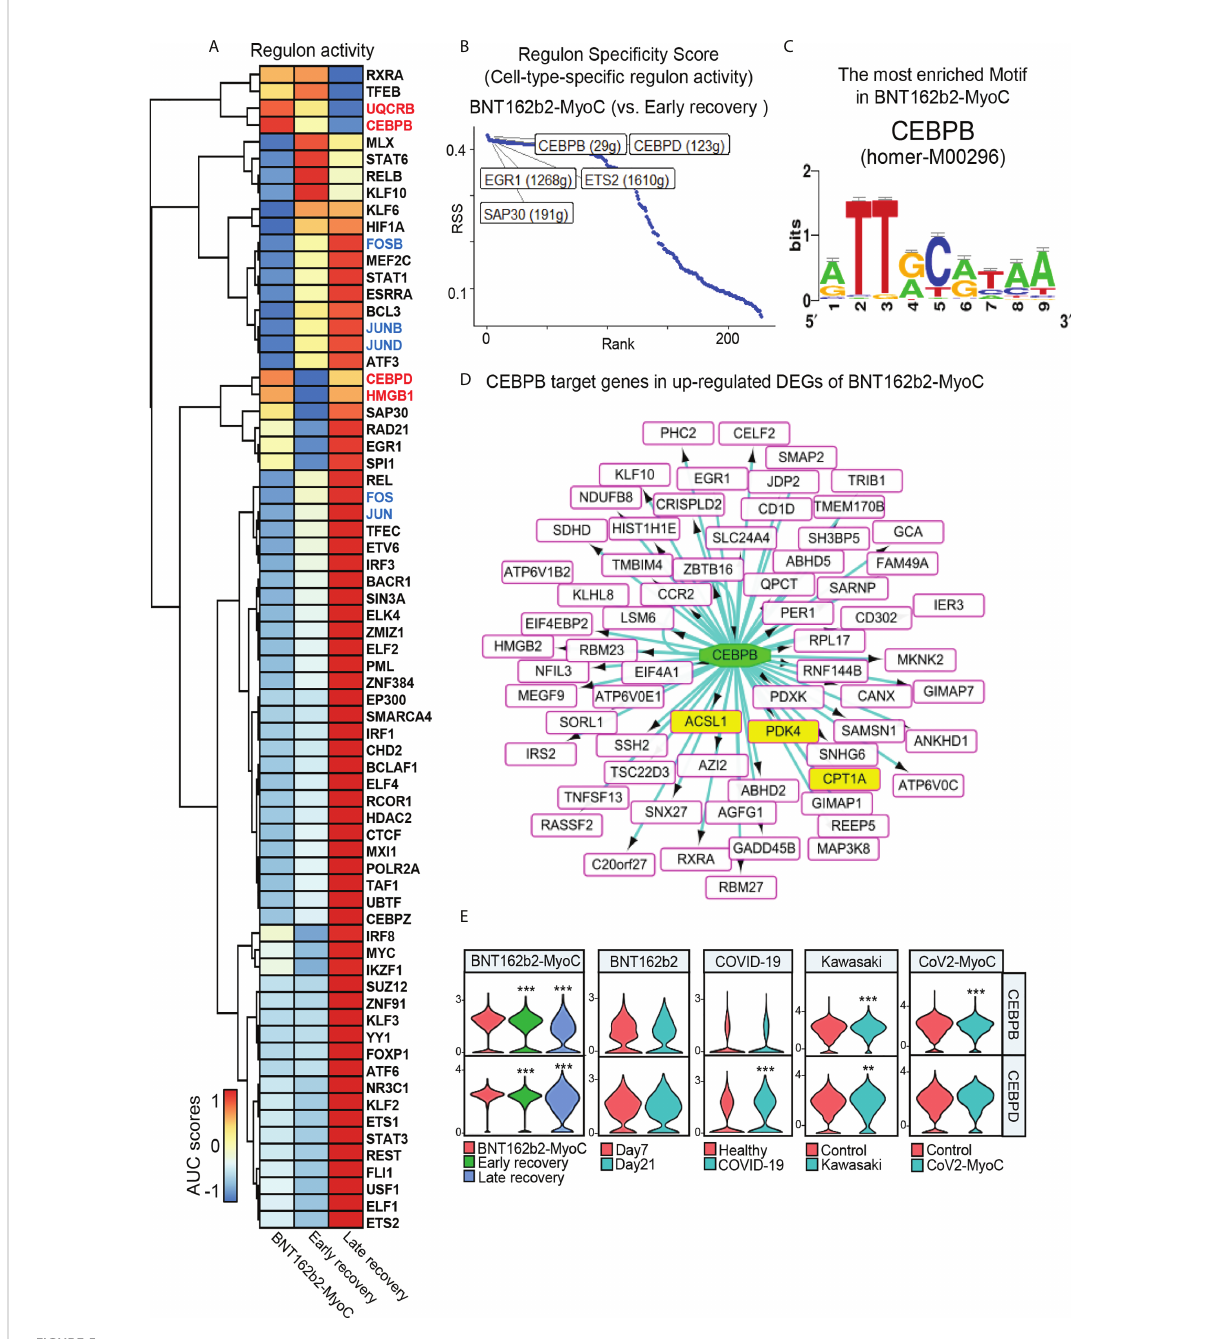
FIGURE 5 CEBPB is the Major Transcription Factor to Mediate Fatty Acid Metabolism in Classical Monocytes in BNT162b2-MyoC Stage. (A) A clustered heat map showing the area under the curve (AUC) scores of expression regulation by transcription factors (TFs), as estimated using SCENIC. (B) Regulons with top 5 cell-type-speci fi c activity in classical monocytes in early recovery stage compared to BNT162b2-MyoC stage. (C) The CEBPB-bound motif, which is the most enriched in classical monocytes in BNT162b2-MyoC (NES score of 5.716 and 23 direct targets genes) predicted by iRegulon. (D) A Network plot showing target genes of CEBPB in up-regulated DEGs of classical monocytes in BNT162b2-MyoC. all target genes as squares. squares fi lle with yellow color are fatty acid metabolism related genes. CEBPB is drawn as a green ellipse. The interactions are shown with directed edges from the CEBPB to the target genes. (E) Normalized expression levels of CEBPB and CEBPD in classical monocytes in each group of datasets. ** p < 0.01; *** p < 0.001; two-tailed t